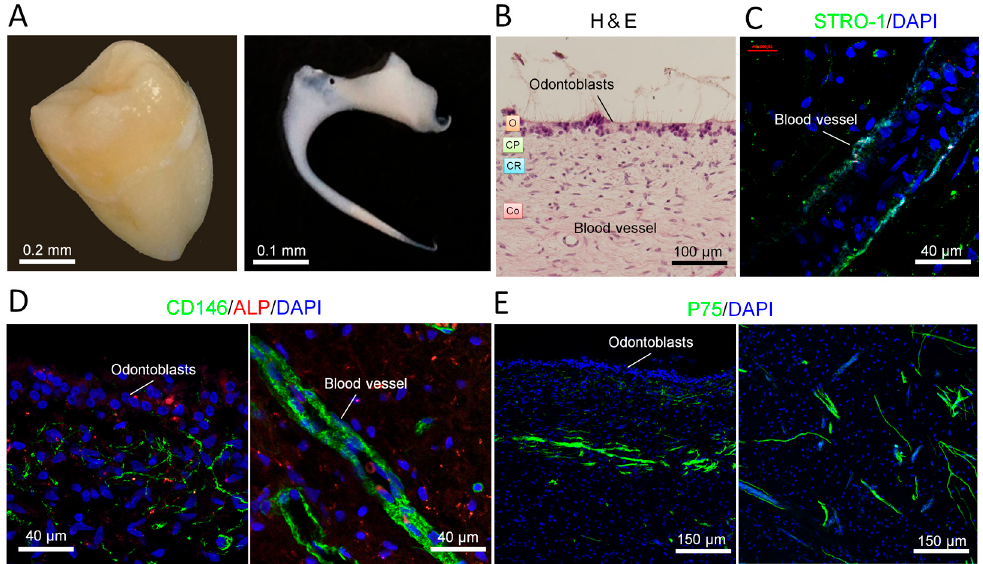
Figure 1. Characterization of human dental pulp: stem cell distribution. ( A ) Digital photos of a human third molar tooth (left) and a human dental pulp from third molar (right); ( B ) Human dental pulp was stained with hematoxylin and eosin (H&E). O, odontoblastic zone; CP, cell poor zone; CR, cell rich zone; Co, core of the pulp; ( C ) Mesenchymal stem cell marker STRO-1 was expressed along the blood vessel. Nuclei were stained with DAPI (4 ′ ,6-diamidino-2-phenylindole); ( D ) Stem cell marker CD146 was expressed at the places near the odontoblasts and along the blood vessel. Alkaline phosphatase (ALP, marker for skeletal mineralization) was detected in the odontogenic zone; ( E ) Neuronal crest stem cell marker P75 was expressed in the core of dental pulp.